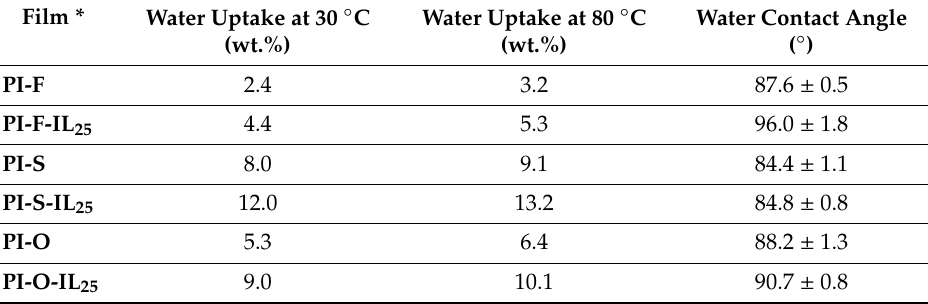
Table 5. Water uptake and water contact angle values of the